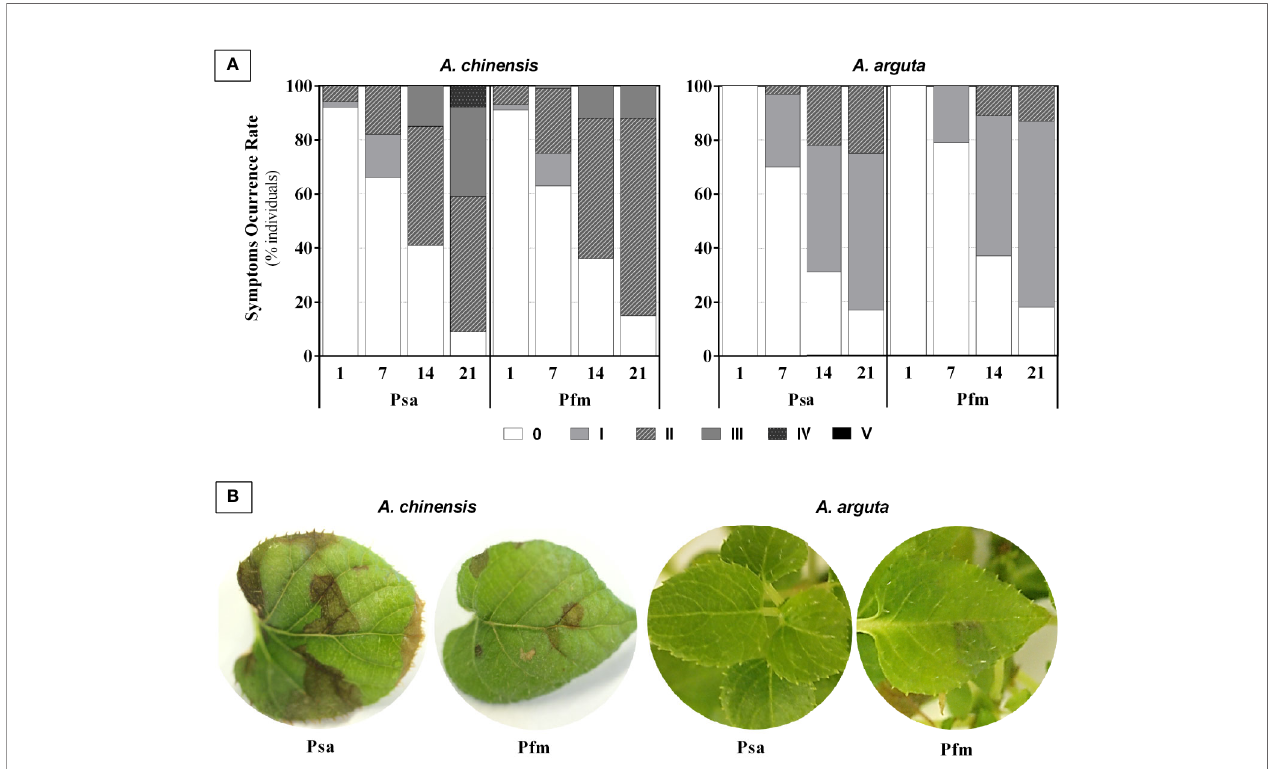
FIGURE 1 | (A) Symptom occurrence rate (percentage of individuals showing disease symptoms) in Actinidia chinensis var. deliciosa cv. ‘ Hayward ’ and A. arguta var. arguta cv. ‘ Weiki ’ plants inoculated with Pseudomonas syringae pv. actinidiae (Psa) or P. syringae pv. actinidifoliorum (Pfm) registered 1, 7, 14 and 21 days post inoculation (dpi). Foliar symptoms were scored taking into account the percentage of leaf area affected by necrotic spots: 0: no symptoms; I: <5%; II: 5 – 9%; III: 10 – 14%; IV: 15 – 19%, V: >20%. (B) Most typical foliar symptoms observed 21 dpi in both kiwifruit species inoculated with Psa or